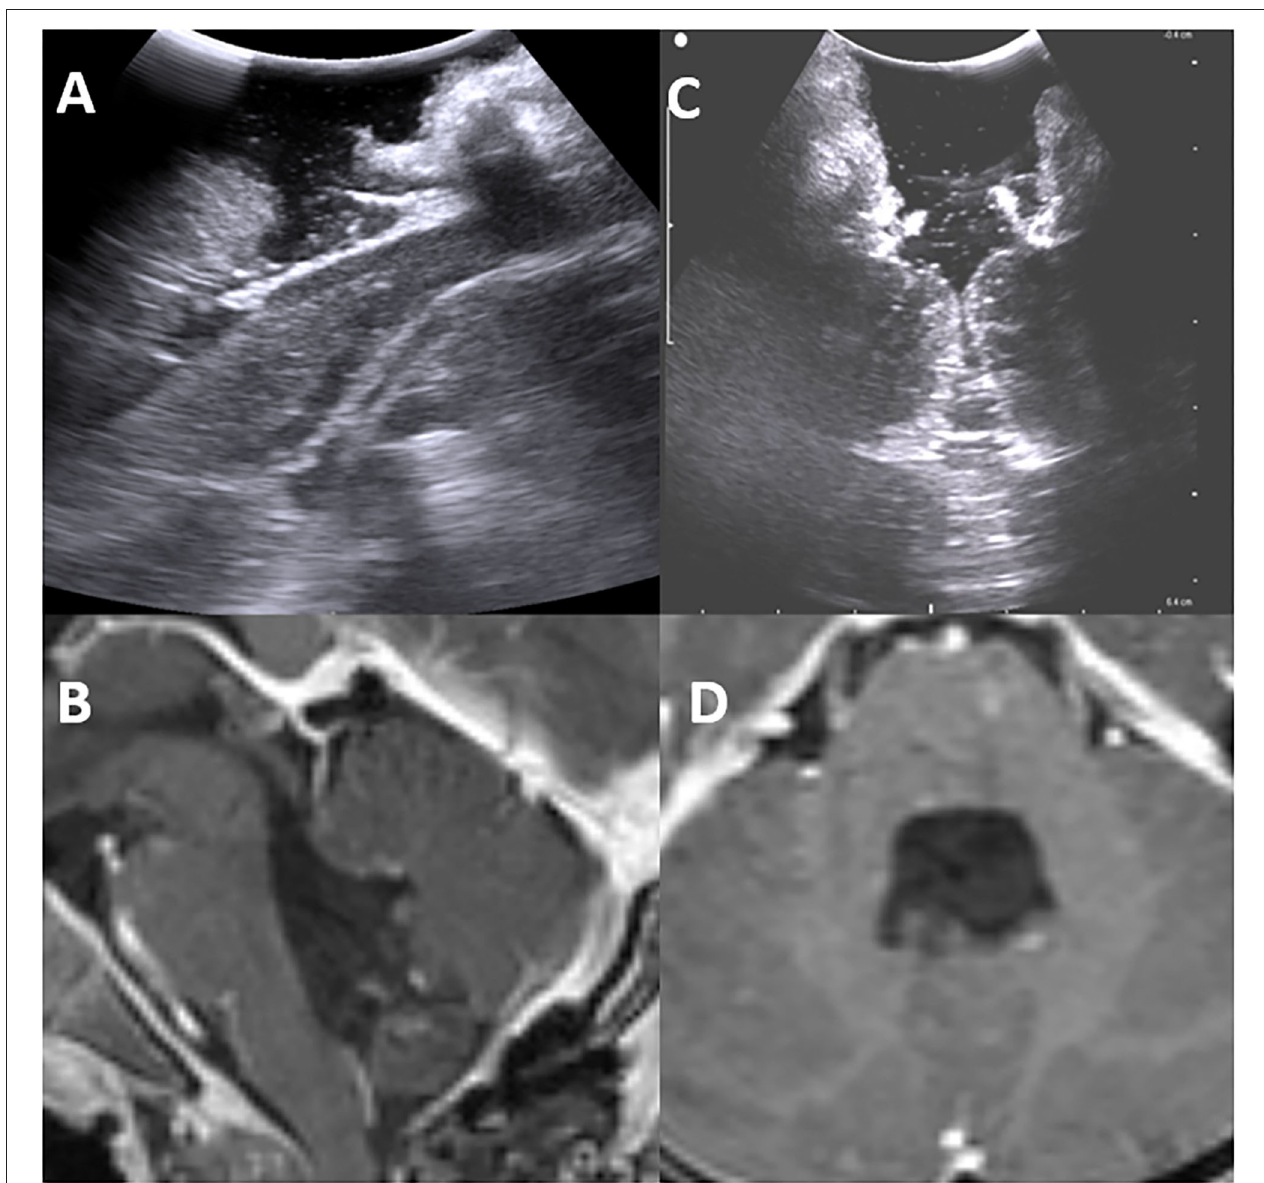
FIGURE 7 | Post-operative intraoperative ultrasound images in sagittal and axial view showing total resection of the lesion (A,C) in concordance with postoperative MRI -TIWI in sagittal and axial views (B,D) .